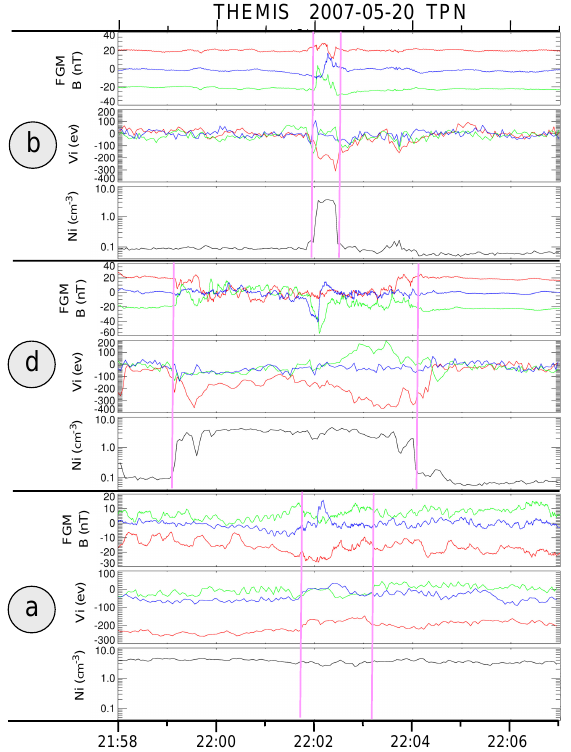
Fig. 5. Similar to Fig. 3, but TPN coordinates are used to display the magnetic field and the velocity. Notice that B N and V N are small on both sides of the event, as expected. The ion velocity is maximum on both sides of the FTE. Here red is for T, green for P and blue for N, the normal